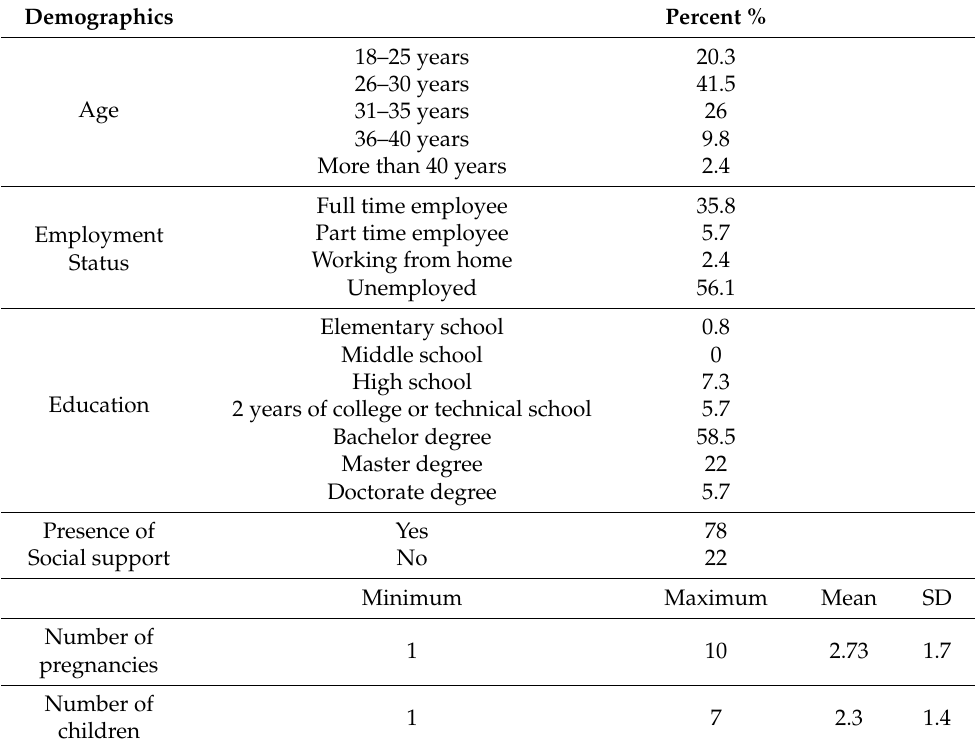
Table 1. Demographic